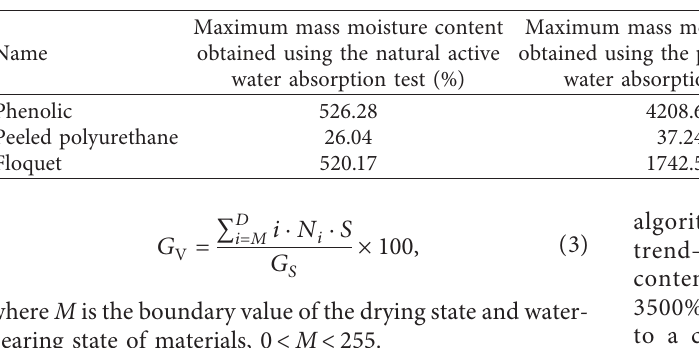
Figure 9: The change curve of the water content in the thermal insulation layer material over time by pressure passive water absorption. (a) Phenolic insulation board. (b) Peeled polyurethane insulation board. (c) Floquet insulation Table 6: Maximum mass water contents of the thermal insulation layer materials.